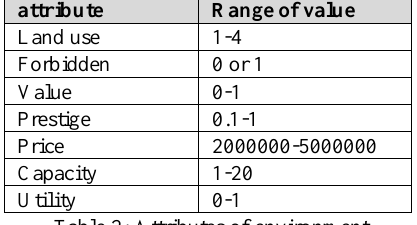
Table 2: Attributes of